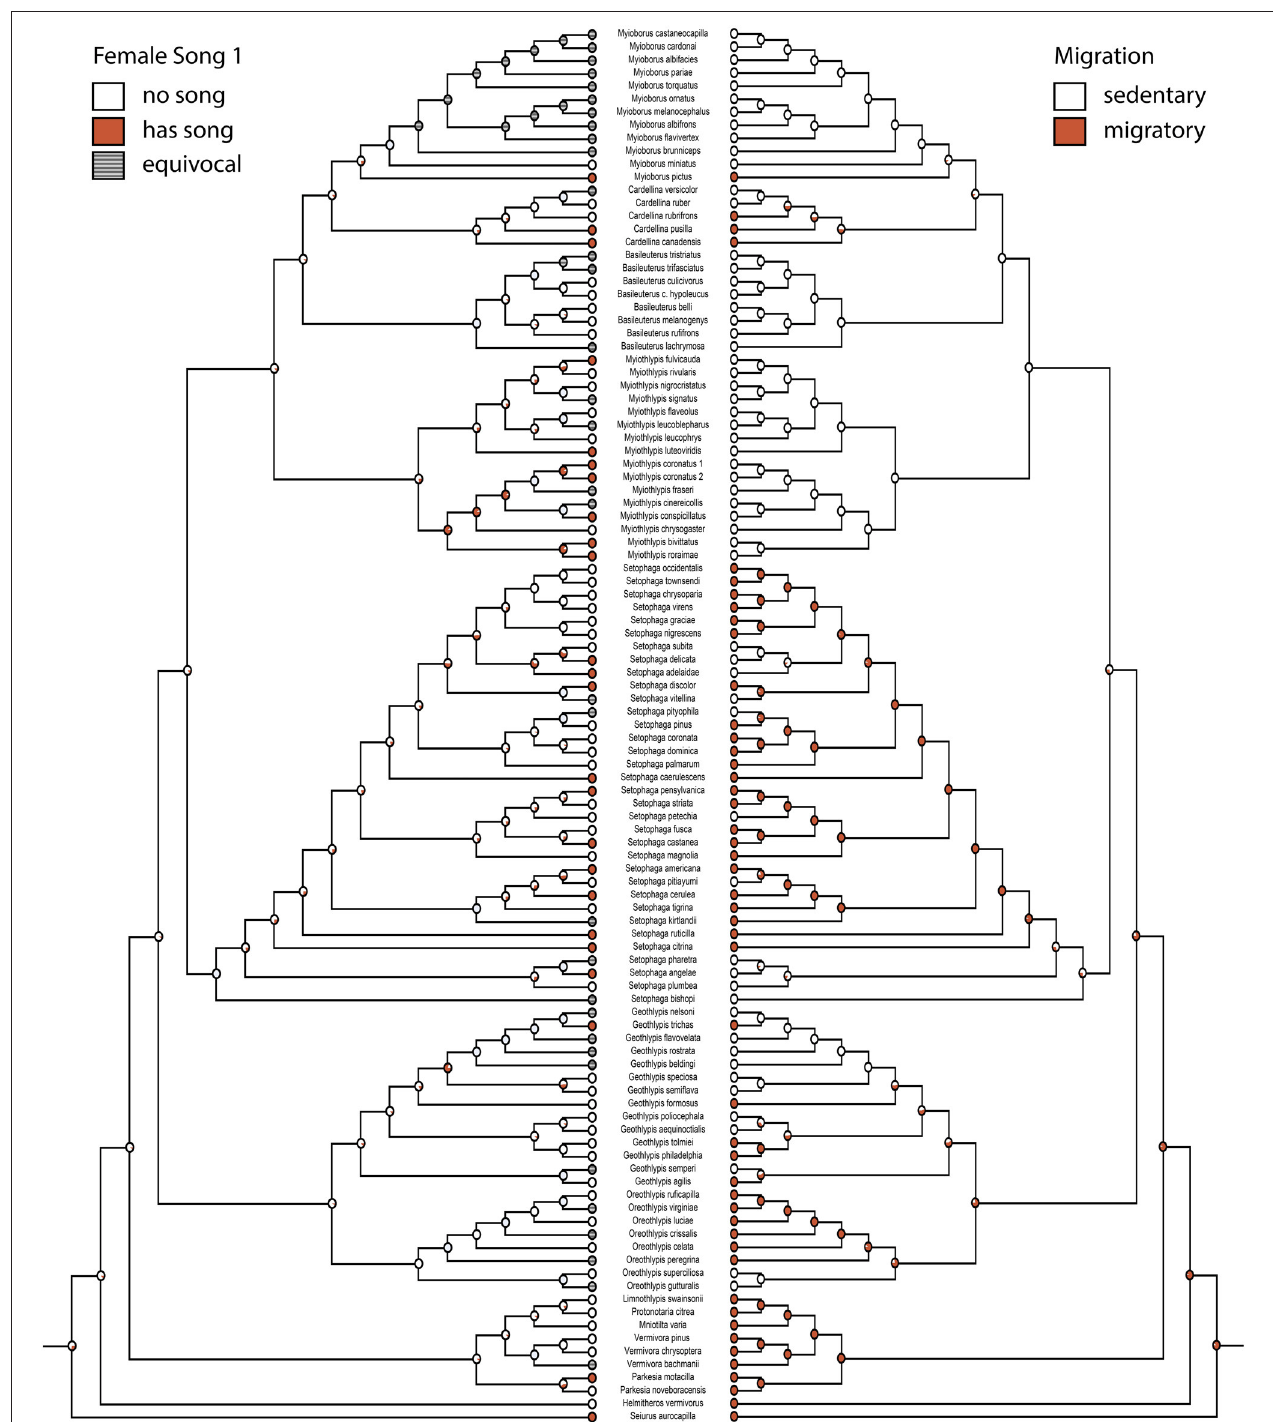
FIGURE 2 | Ancestral state reconstruction for female song 1 (mk2, log likelihood: − 45.95) mirrored with migration (mk1, log likelihood: − 46.81). Red circles have female song or are migratory, white circles do not. Gray circles are equivocal. Pie charts indicate proportional likelihoods.